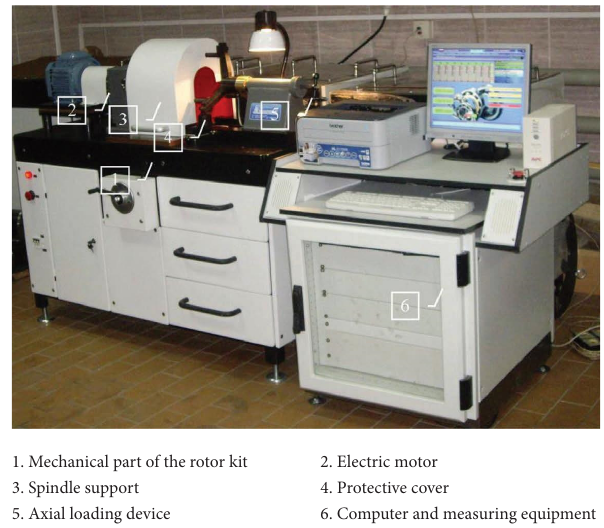
Figure 1: Rotor kit for vibration tests of rolling bearings.